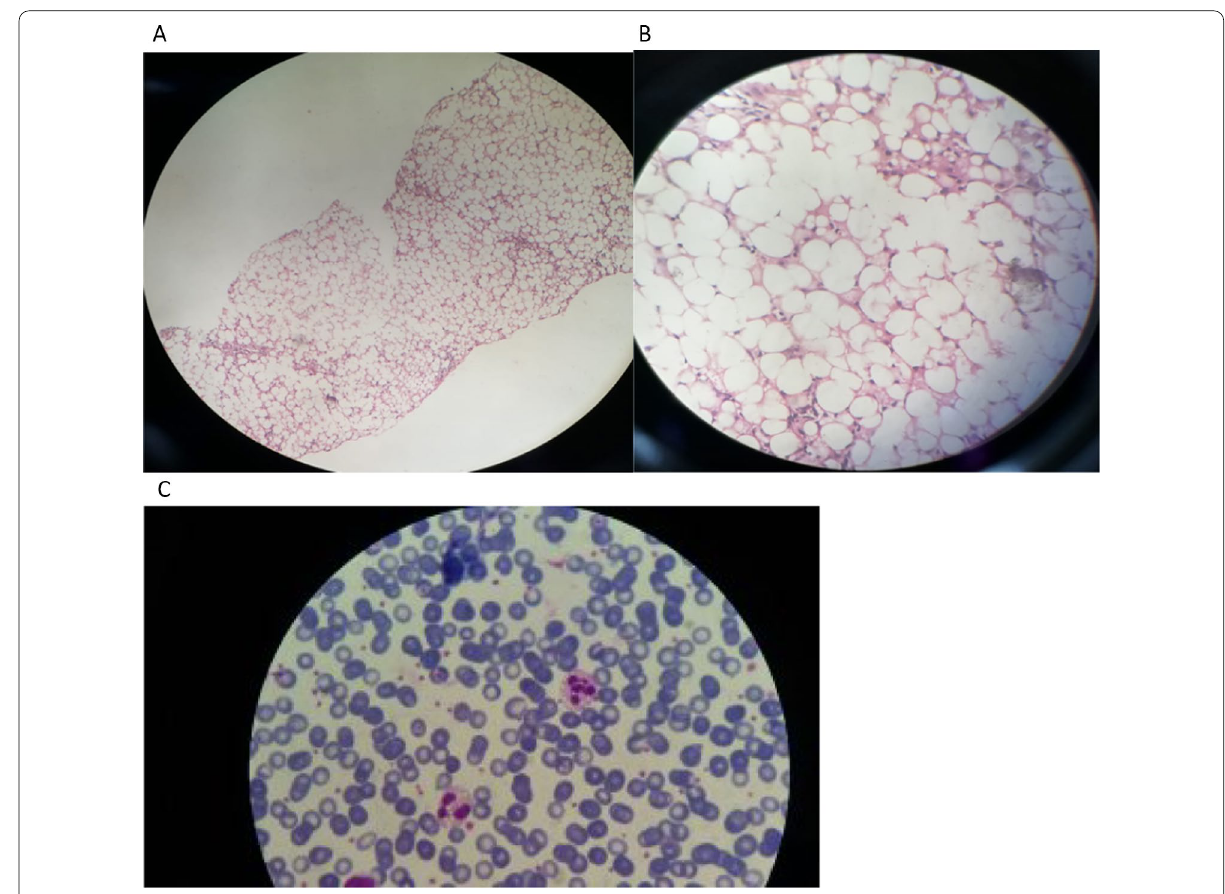
Fig. 1 Liver histology and Jordan’s anomaly in a CDS patient (case 2). ( a ) Liver parenchyma (H&E) shows distorted lobular architecture and expanded portal areas. Trichrome stain reveals portal and periportal fibrosis along with many thin fibrous septa suggestive of steatohepatitis with fibrosis. ( b ) Higher magnification shows hepatocytes are enlarged with compressed sinusoids and severe pan lobular steatosis. ( c ) Microphotographs of May–Grünwald–Giemsa buffy coats showing Jordan’s